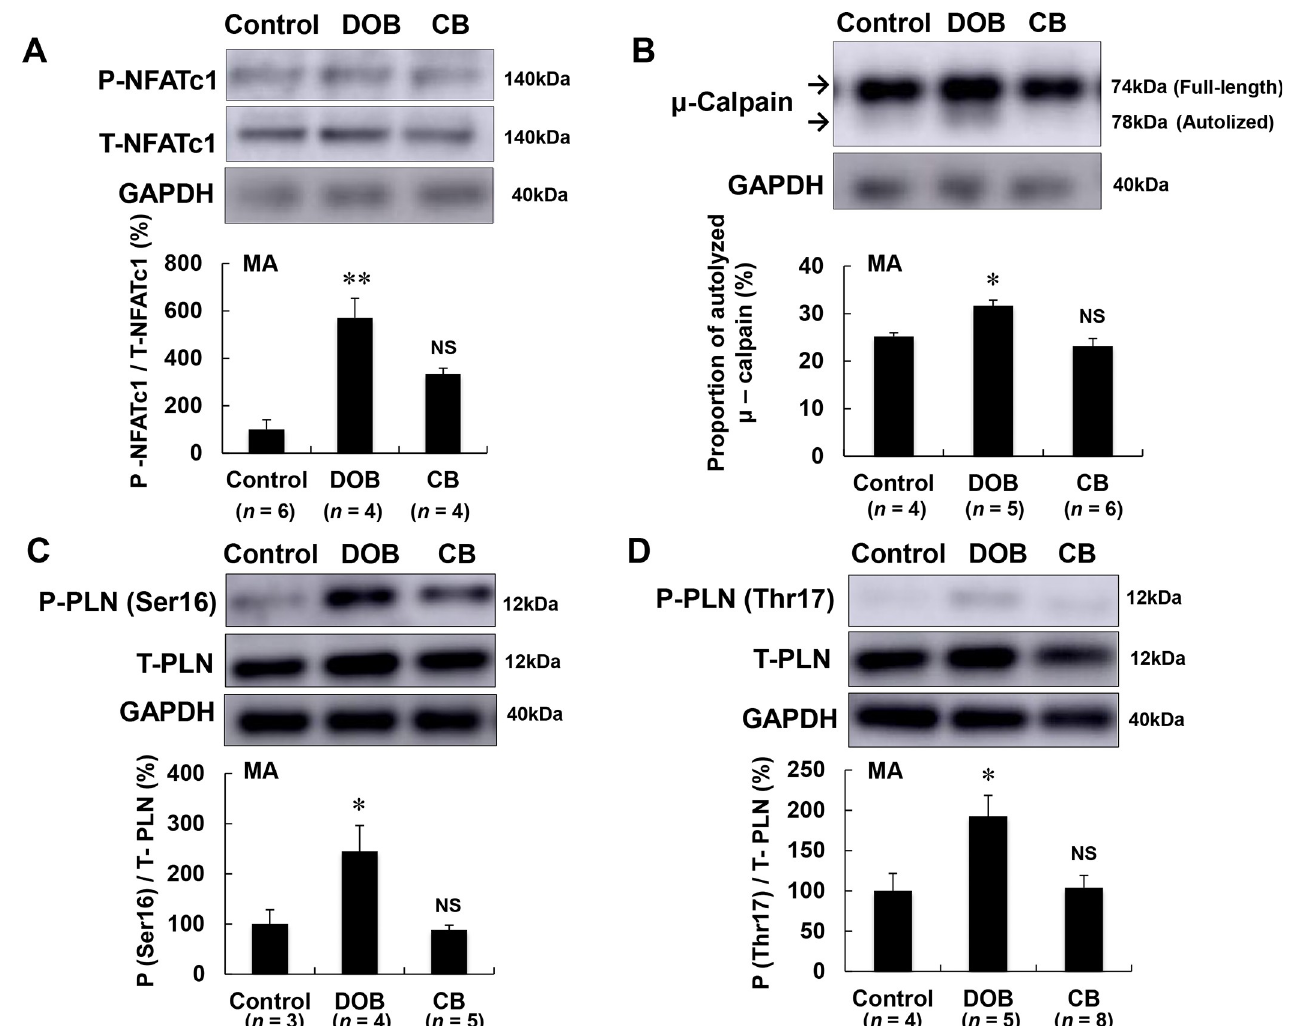
Fig 7. Effects of DOB and CB on Ca 2+ homeostasis and PLN phosphorylation in masseter muscle. (A) NFATc1 phosphorylation on serine 259 was significantly greater in masseter muscle of the DOB group compared with the control group ( � P < 0.05 vs. Control), but this was not the case in the CB group. (B) The calculated μ -calpain fractional activation index (i.e., percentage of autolysed calpain) was significantly increased in the DOB group ( �� P < 0.01 vs. Control), but not in the CB group. (C) PLN phosphorylation (Ser-16) was significantly increased in the DOB group ( � P < 0.05 vs. Control), but not in the CB group. (D) PLN phosphorylation (Thr-17) was significantly increased in the DOB group ( � P < 0.05 vs. Control), but not in the CB